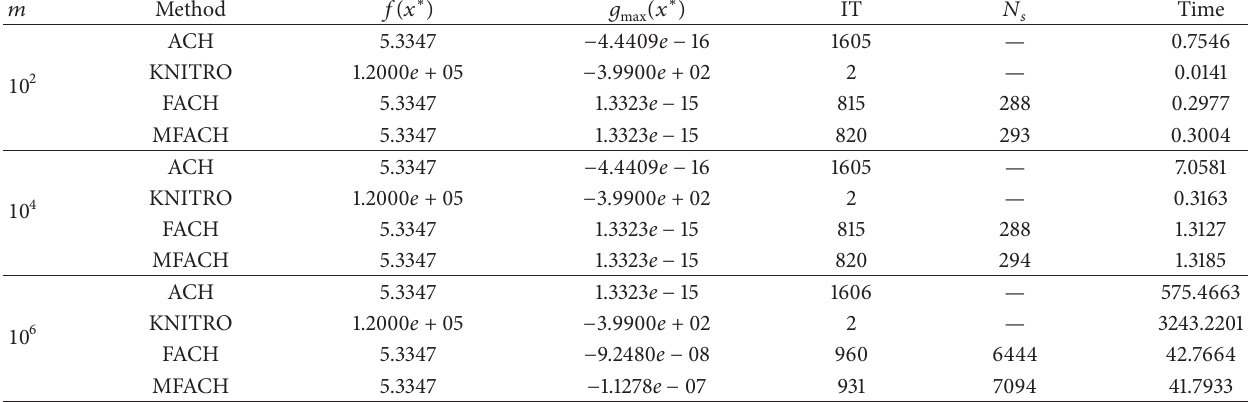
Table 4: Test results for Example